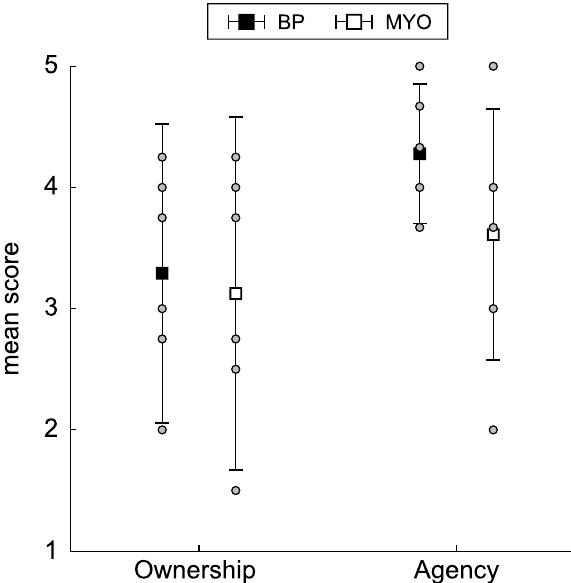
Figure 2. Self-reported embodiment. Mean ownership and agency scores for BP and MYO users. Error bars represent standard deviation across subjects and individual points represent individual participant